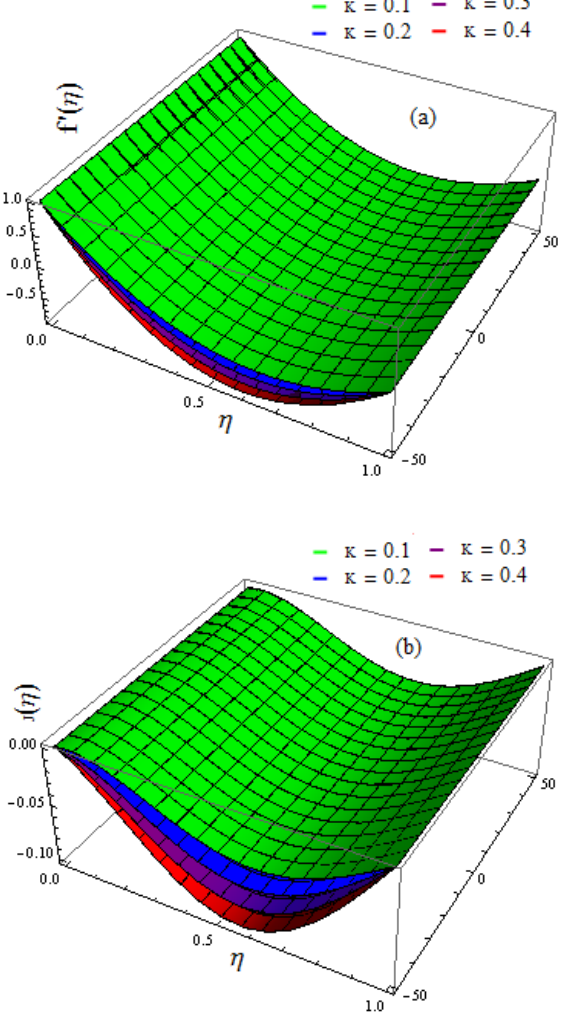
Figure 5. ( a ) Influence of K on f (cid:48) ( η ) . ( b ) Influence of K on J ( η ) Figure 5. ( a ). Influence of 𝐾 on 𝑓 ′ (𝜂) . ( b ) Influence of 𝐾 on 𝐽(𝜂) .